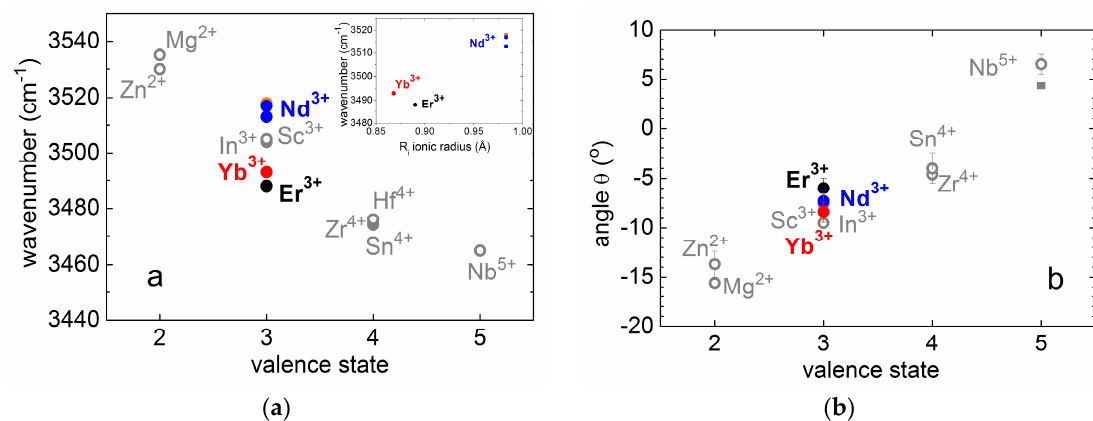
Figure 3. ( a ) Vibrational frequencies of the OH – ions in rare-earth doped sLN crystals together with those observed for ODR ion doped sLN [4]. The inset shows the vibrational frequency of the OH – ion as a function of the ionic radius of the RE 3+ dopant. ( b ) The angle θ between the O–H dipole and the oxygen plane perpendicular to the Z axis of the LiNbO 3 crystal.